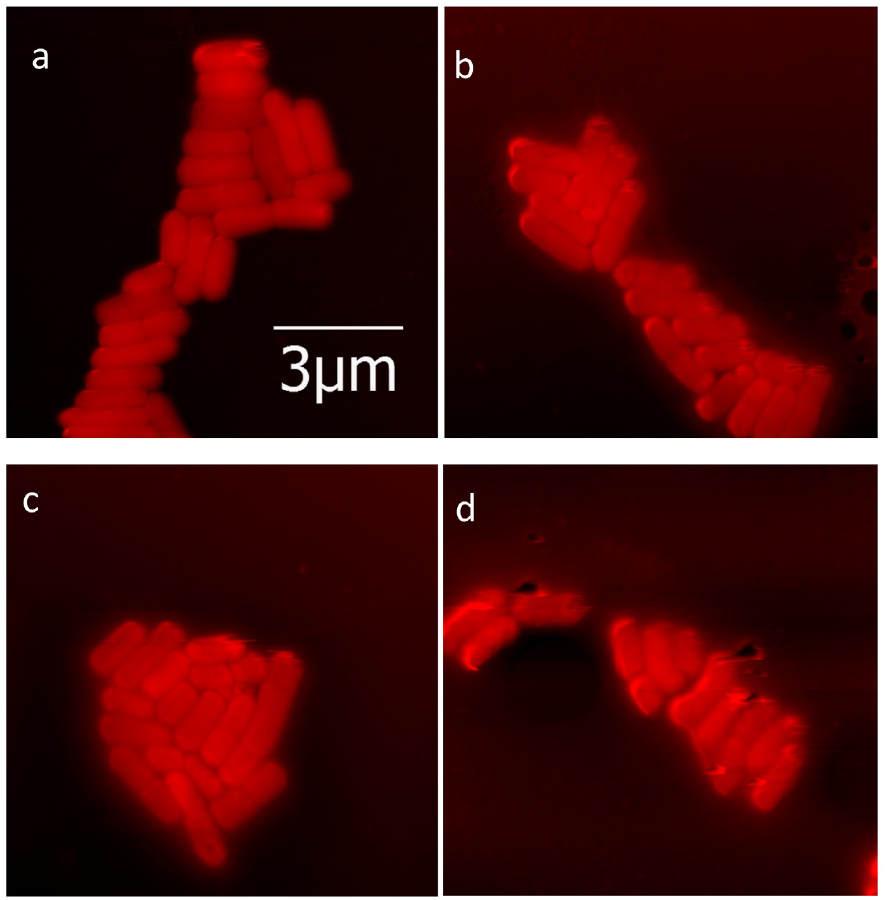
Fig 1. Shaded AFM images of Listeria innocua (a, c) nonresistant and (b, d) BAC-resistant strains (a, b) before and (c, d) after BAC exposure. Scale bar applies to all